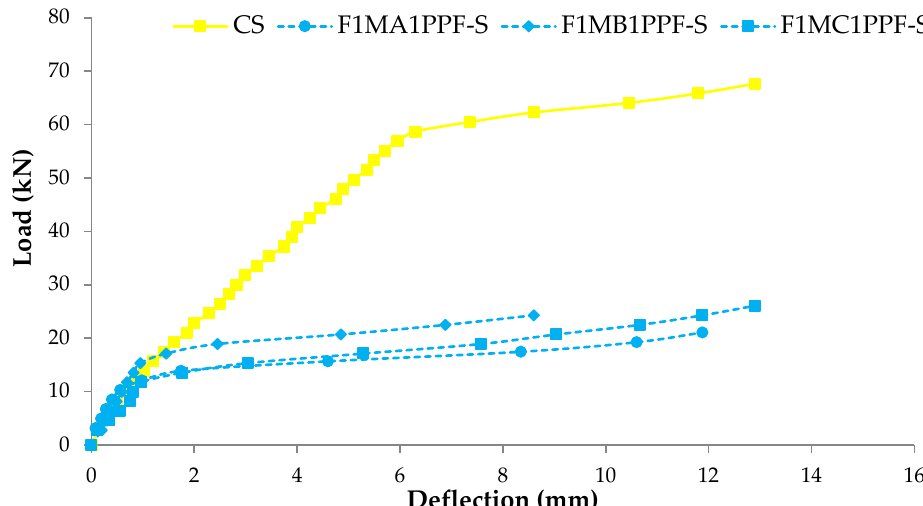
Figure 13. Comparison of load-deflection of group C1 with CS slab.